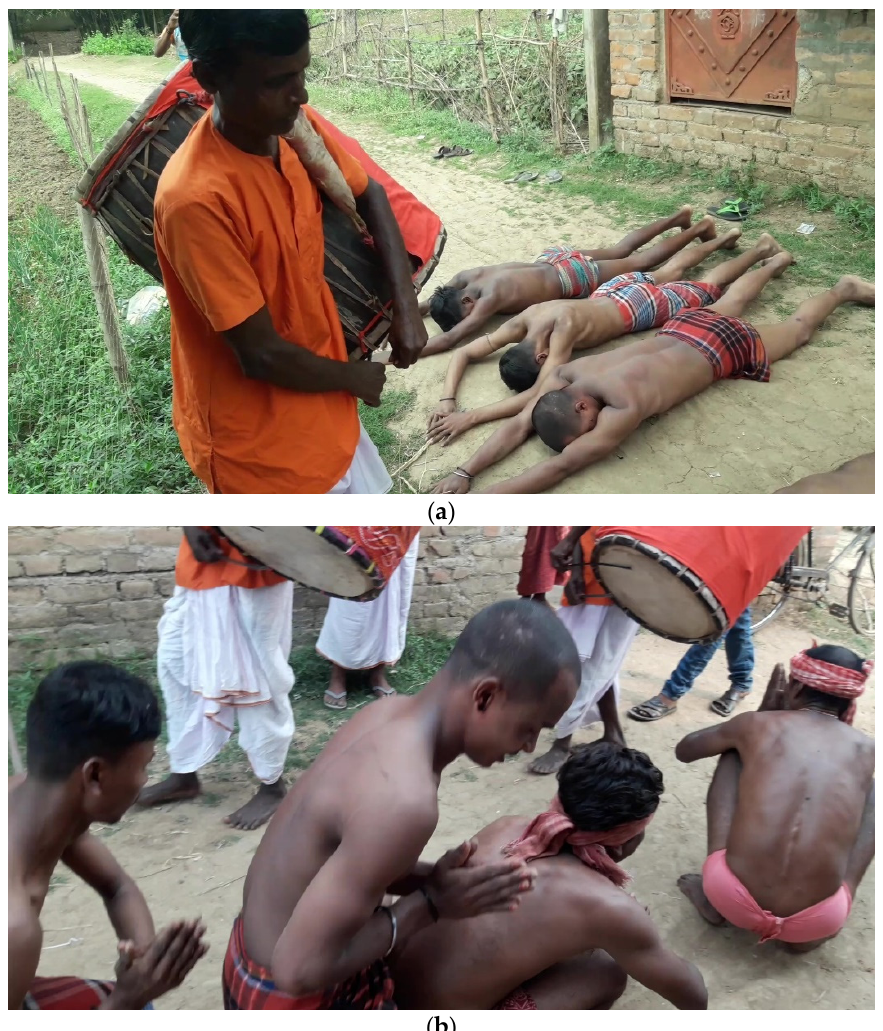
Figure 4. ( a , b ): Murshidabad villagers prostrating to the sound of dhak